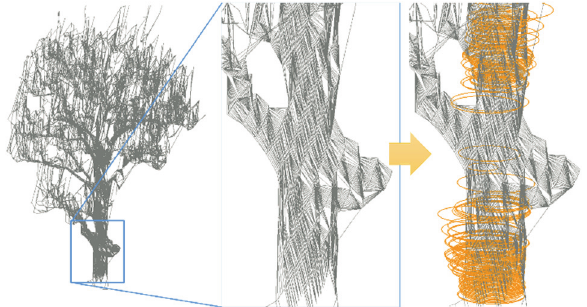
Figure 8 . A roadside tree with a hump around 1.2 m and the extracted circles